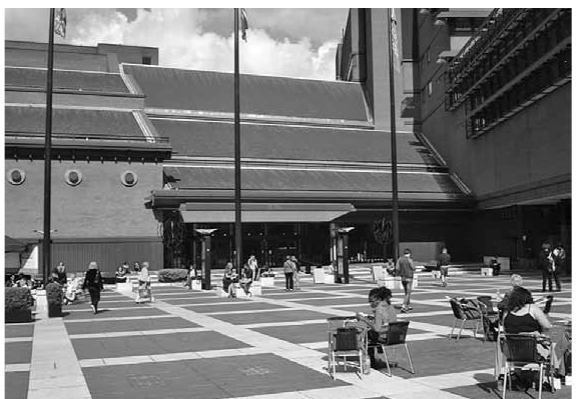
fig. 4. Bibliotech